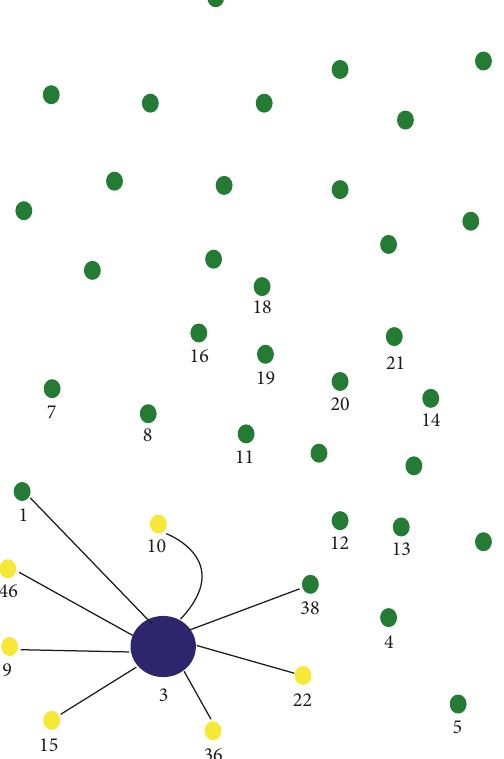
Figure 6: Node 3 sends information to other nodes.